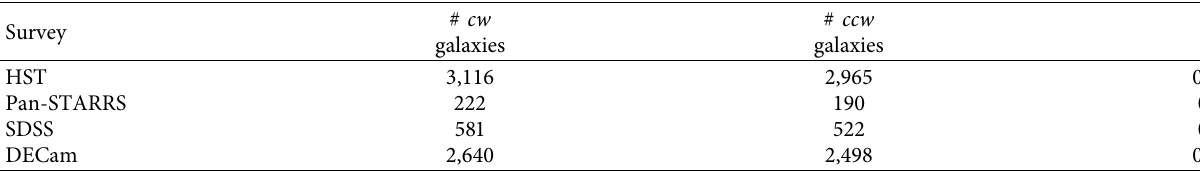
Table 7: The number of clockwise and counterclockwise galaxies in the COSMOS field, and in the 10 o × 10 o field of SDSS, Pan-STARRS, and DECam centered at COSMOS. The P values are the one-tail binomial probabilities [81] of having asymmetry equal or greater than the observed asymmetry when the probability of a galaxy to spin in a certain direction is 0.5.